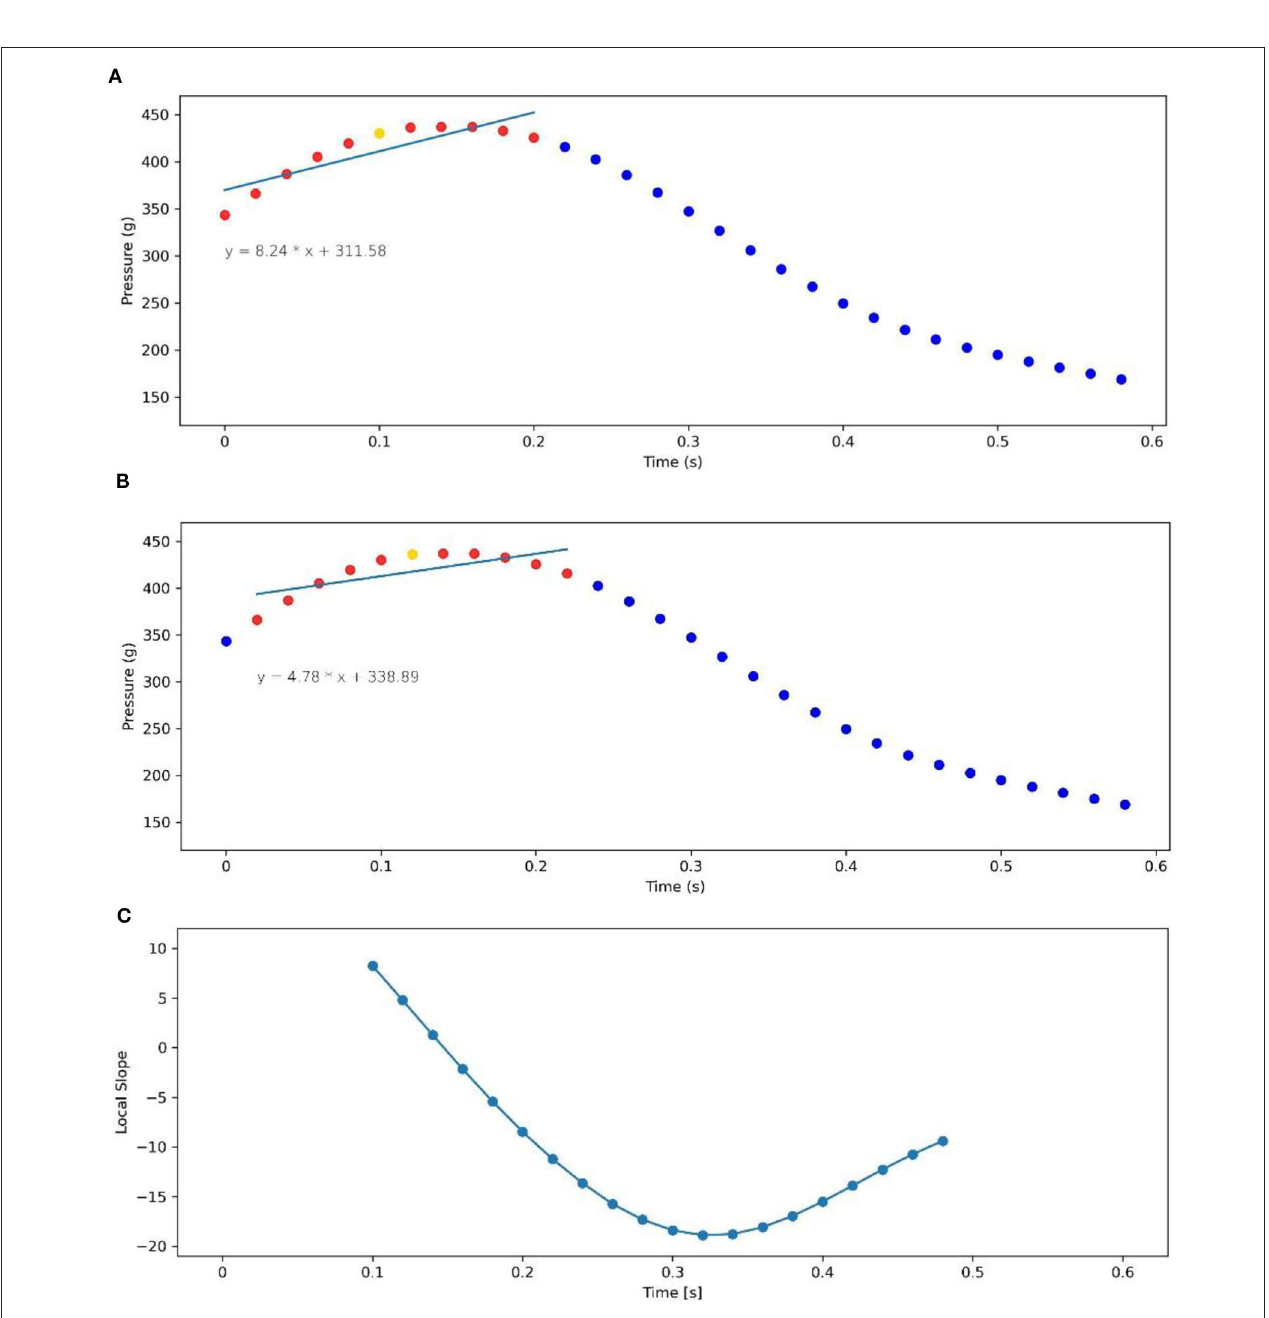
FIGURE 3 | Illustration of the preprocessing operation of partial slope extraction. (A) Aims to extract the slope of the position of 0.1s and the corresponding least-squares fitting line. (B) Intends to extract the slope of the position of 0.12s and the corresponding fitting line. (C) It is the local slope after data preprocessing, each point of the local slope corresponding to the original pressure data of local trends. A total of 20 local slopes are extracted excluding the auxiliary calculation points.